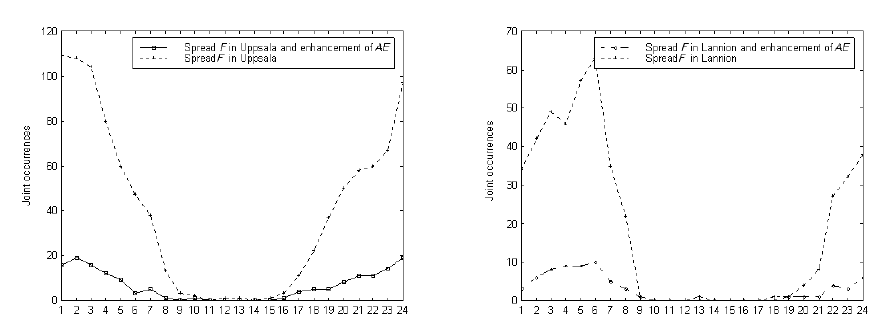
Fig. 12.8. Daily variation of the simultaneous occurrence of spread- F and AE enhancements (Bencze and Bak- ki,